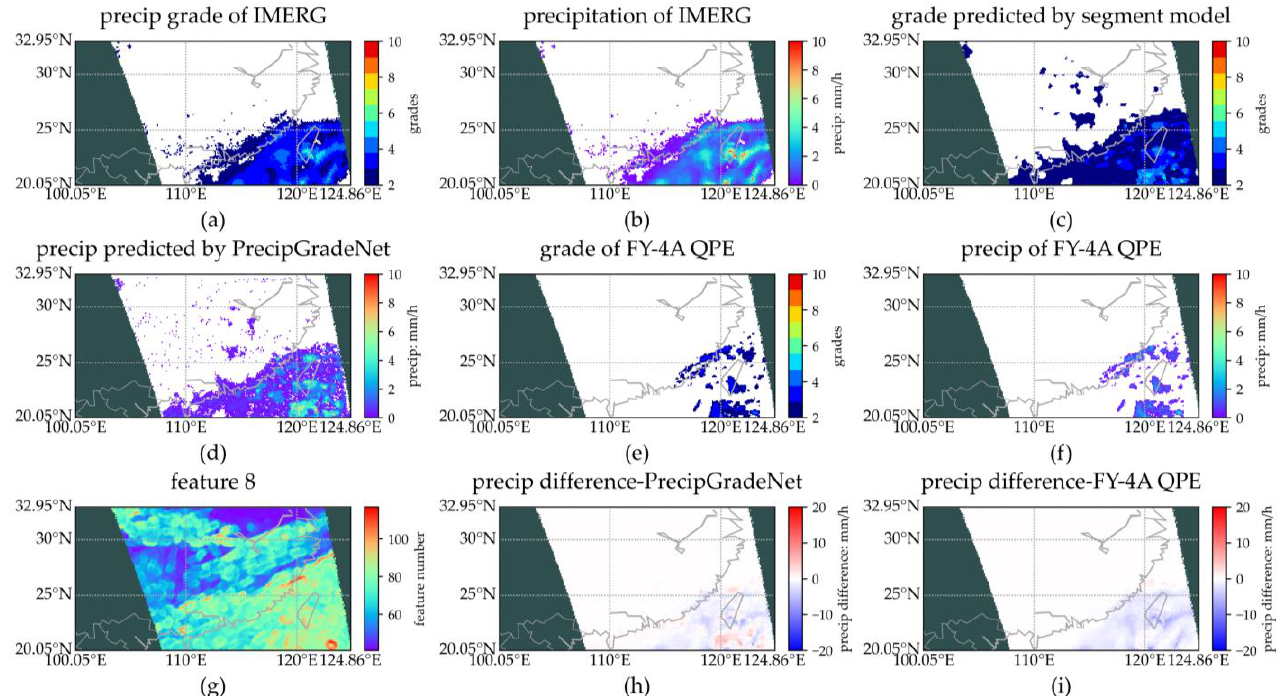
Figure 10. Comparison of precipitation grade and precipitation of IMERG, retrieval model, and FY-4A L2 QPE during 2022-05-02T13:00:00 UTC (( a ) precipitation grade of IMERG; ( b ) precipitation of IMERG; ( c ) grade predicted by segment model of PrecipGradeNet; ( d ) precipitation predicted by PrecipGradeNet; ( e ) precipitation grade of FY-4A L2 QPE; ( f ) precipitation of FY-4A L2 QPE; ( g ) the feature 8 brightness temperature different; ( h ) precipitation difference between PrecipGradeNet estimation and IMERG; ( i ) precipitation difference between FY-4A L2 QPE and IMERG).